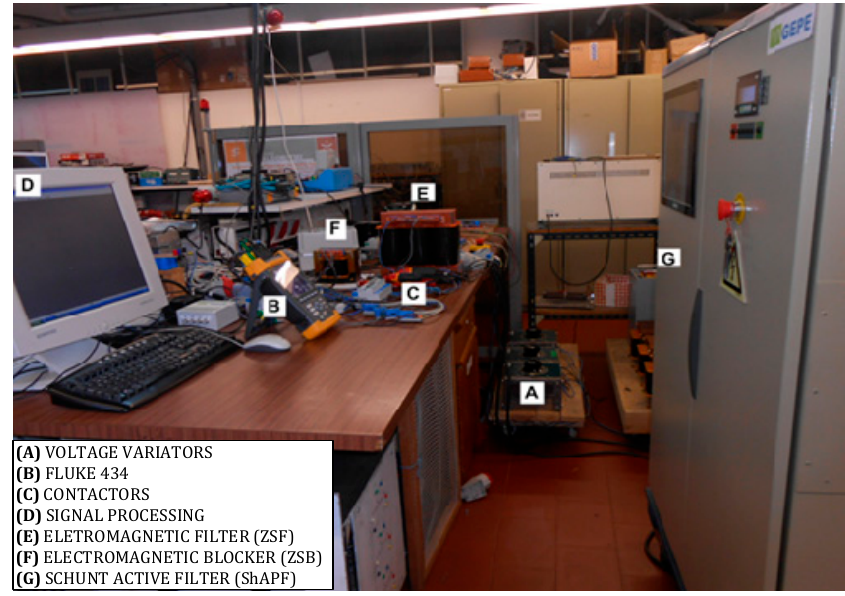
Figure 24. General overview of the workbench used in the experimental tests.